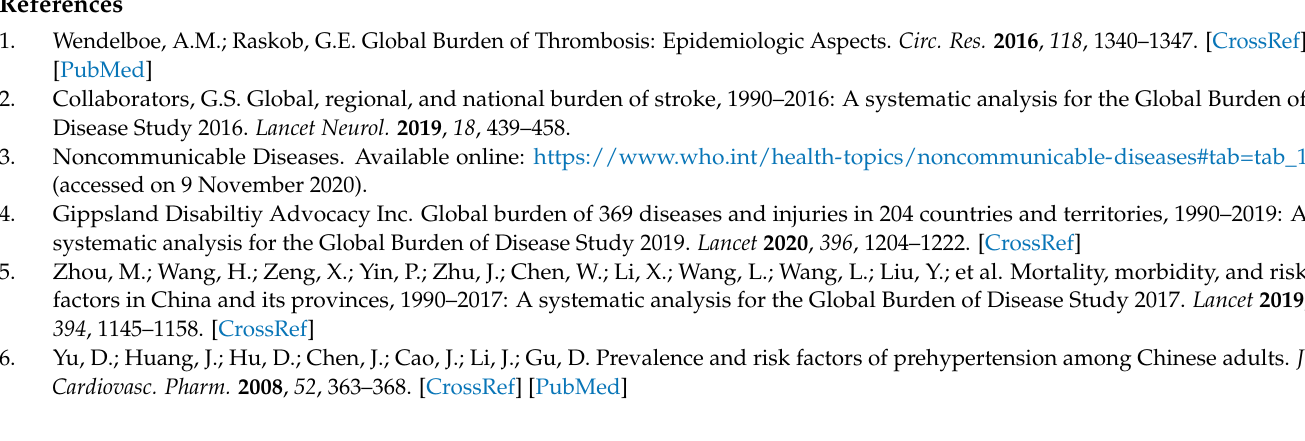
Figure S4: The blood pressure trajectories in the 2-class and 4-class models of diastolic blood pressure by GMM for myocardial infarction, Figure S5: The blood pressure trajectories in the 3-class model of systolic blood pressure by GMM for stroke, age-stratified, Figure S6, The blood pressure trajectories in the 3-class model of diastolic blood pressure by GMM for stroke, age-stratified, Figure S7: The blood pressure trajectories in the 3-class model of systolic blood pressure by GMM for myocardial infarction, age-stratified, Figure S8: The blood pressure trajectories in the 3-class model of diastolic blood pressure by GMM for MI,